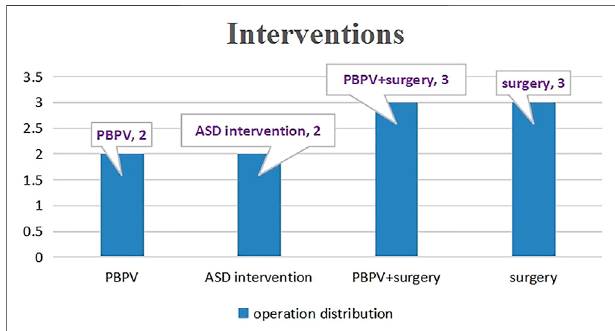
FIGURE 3 | Operation distributions in interventions